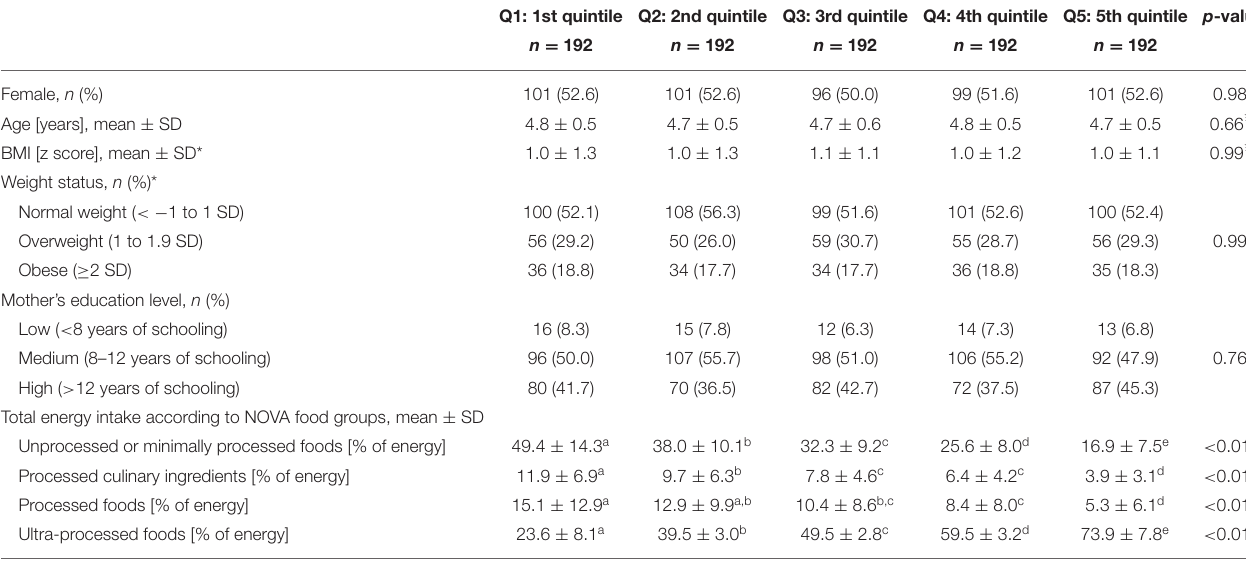
Chi-squared test across UPF intake quintiles (i.e., 1st quintile, 2nd quintile, 3rd quintile, 4th quintile, and 5th quintile); different letters indicate significant differences between quintiles. U One-way ANOVA across intake UPF quintiles (i.e., 1st quintile, 2nd quintile, 3rd quintile, 4th quintile, and 5th quintile); different letters indicate significant differences between quintiles. P-values < 0.05 were considered statistically different.